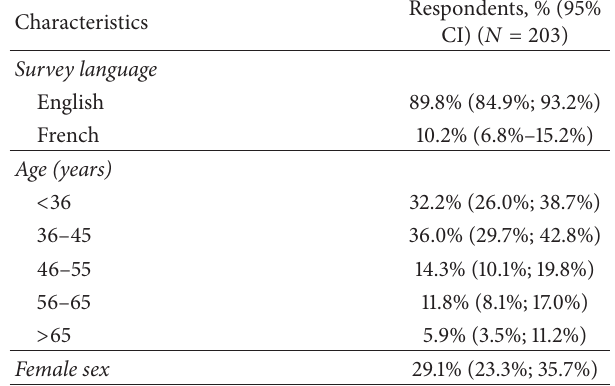
Table 1: Baseline characteristics of